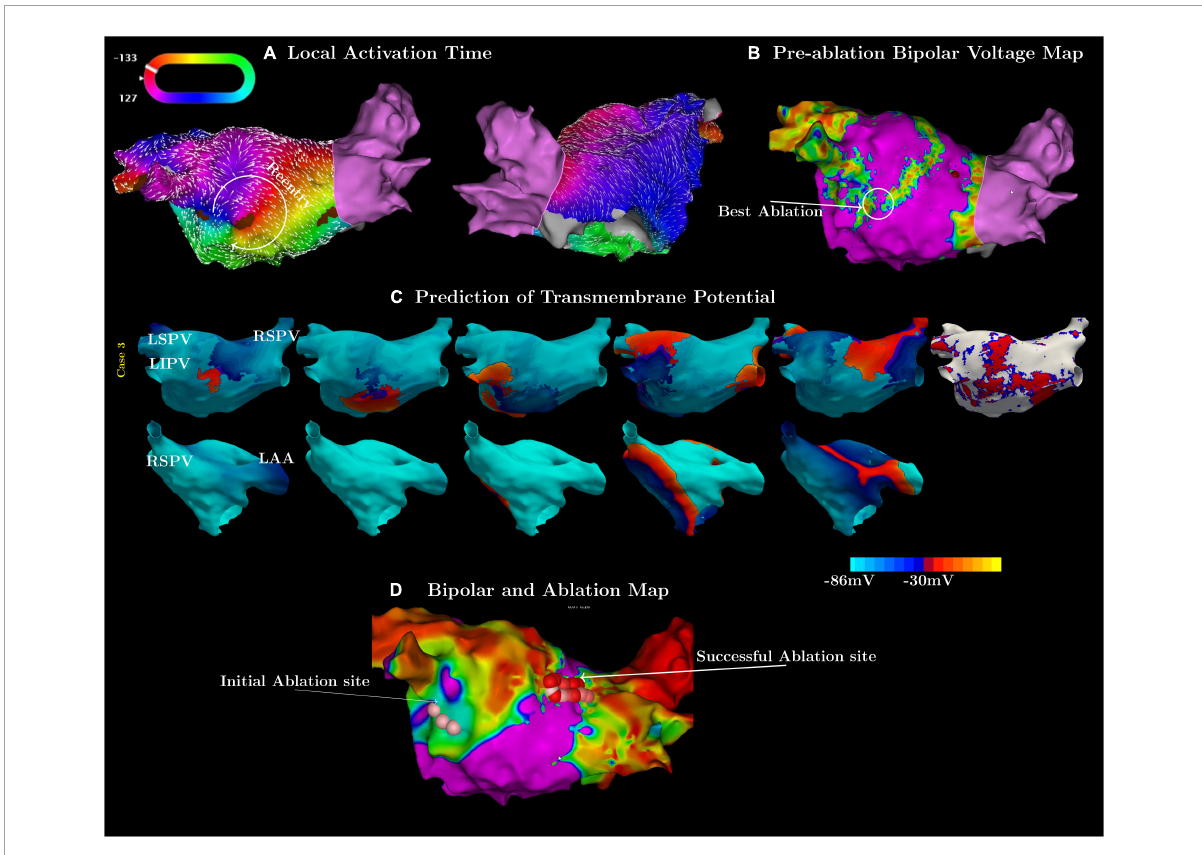
FIGURE2 Examples in which the simulations were more accurate in predicting flutter circuits than high-density mapping. (A) Contains the pre-ablation activation map and (B) the associated bipolar voltage maps of the flutter. (C) Shows the simulated flutter with an isthmus on the posterior wall. (D) Shows a post-ablation map labeled with the initial (pink spheres), failed first ablation site, and the subsequent (red spheres), successful site of